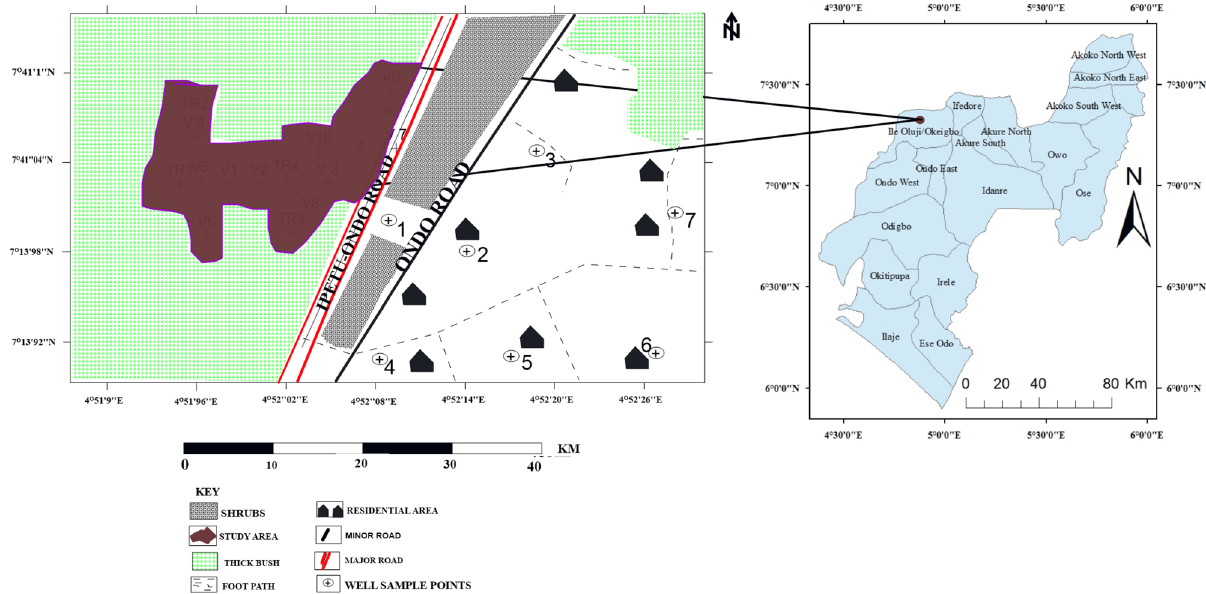
Figure 1. The Map of Ondo State showing the study